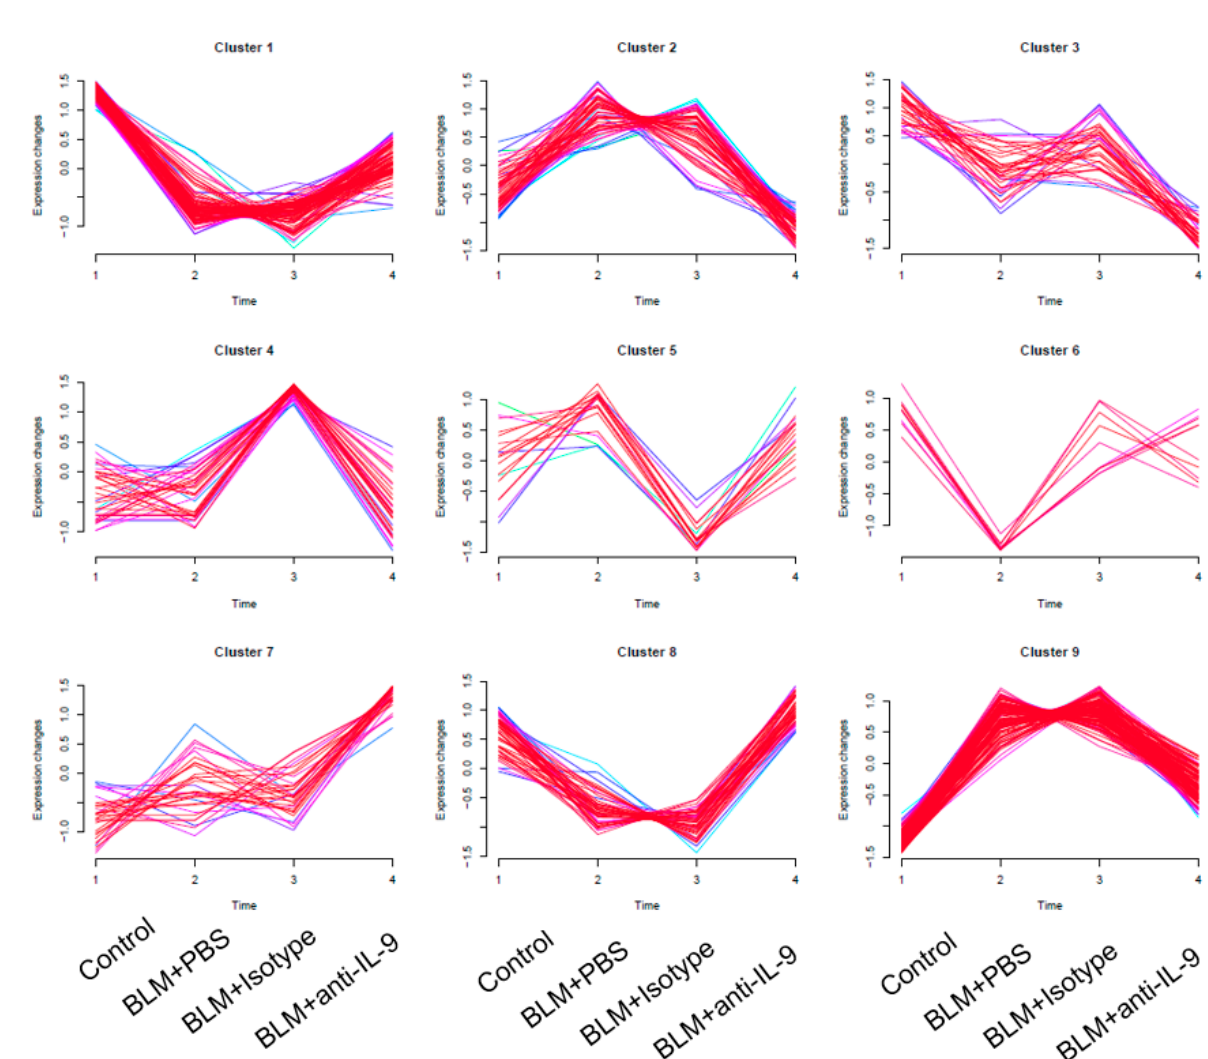
Figure 7. Proteomics analysis of lung homogenates from mice of four groups (therapeutic intervention). ( A ) Heatmap representation of abundance profile of all differentially expressed proteins in four groups. ( B ) Network diagram showing interactions between proteins extracted from STRING database. MCODE method was used to calculate clusters. Six clusters were identified. ( C ) GO-based enrichment and KEGG pathway enrichment analysis of proteins. ( D ) Clustering of proteome expression profiles.